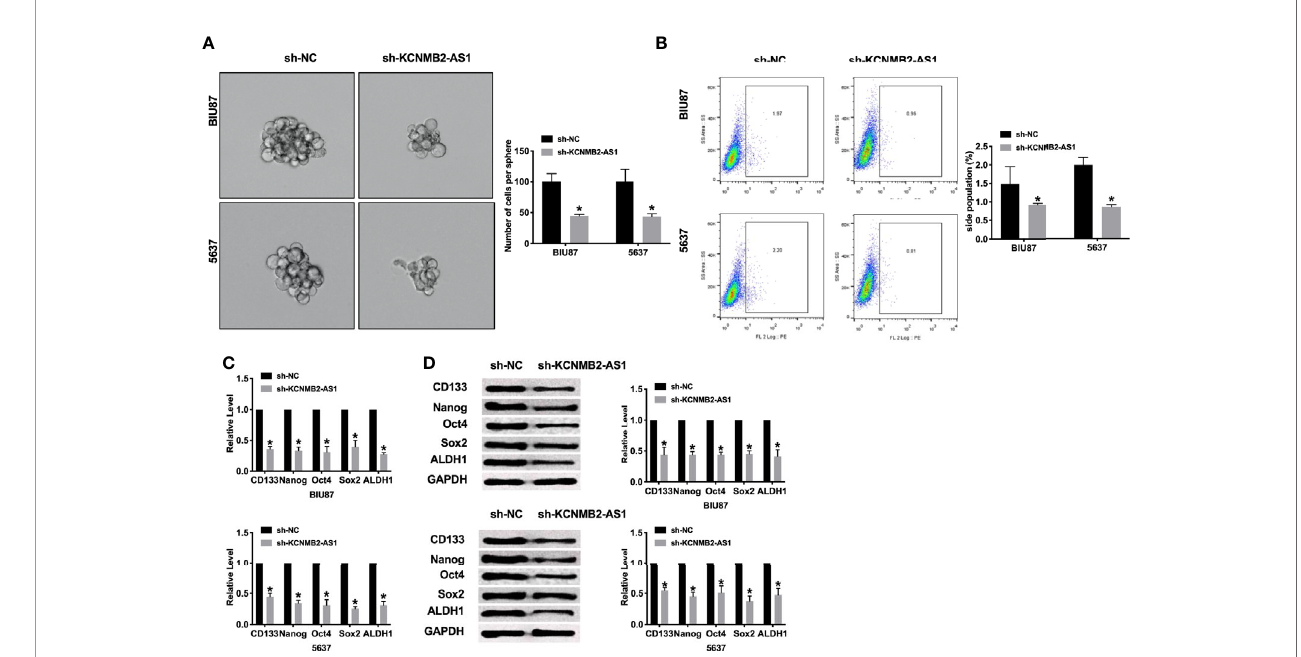
FIGURE 3 | Inhibition of KCNMB2-AS1 suppressed cancer stem cell properties. (A) Tumor sphere-forming ability was assessed. n = 6. (B) The side population of bladder cells was determined by fl ow cytometry. n = 5. (C) The mRNA level of CD133, Nanog, Oct4, Sox2, and ALDH1 was detected by RT-PCR. n = 10. (D) The protein level of CD133, Nanog, Oct4, Sox2, and ALDH1 was detected by western blot. n = 5. * P <